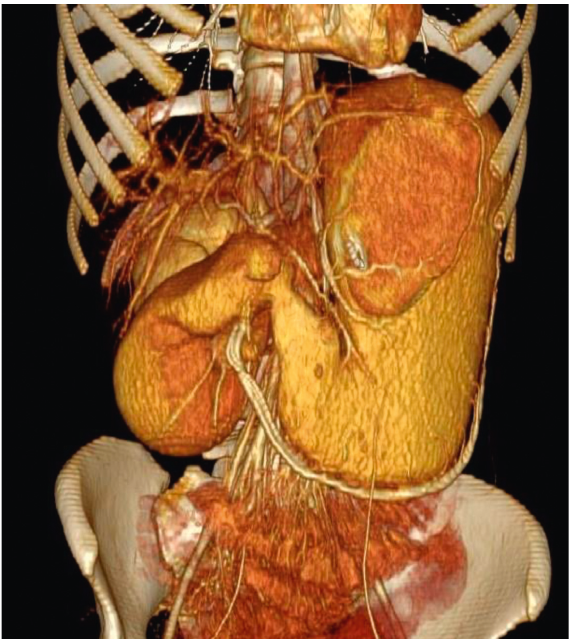
Figure 3: 3D reconstructed CT angiography revealing severely distended stomach and first and second portion of the Table 1: Review of reported cases of SMA syndrome following chemotherapy.